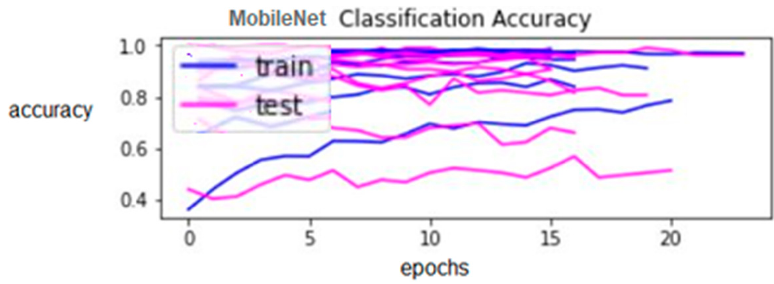
Figure 4. MobileNet model accuracy.